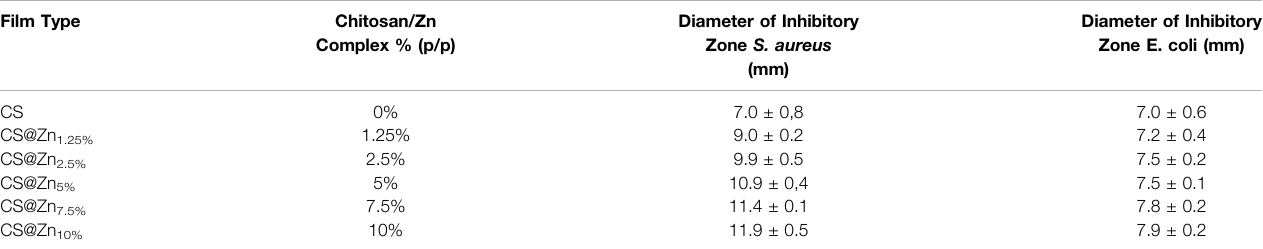
TABLE 2 | The diameter (mm) of the inhibition zone of CS and CS@Zn n fi lms including the diameter of the disk (6 mm). The data are reported as the average of four determinations ±SD. Film